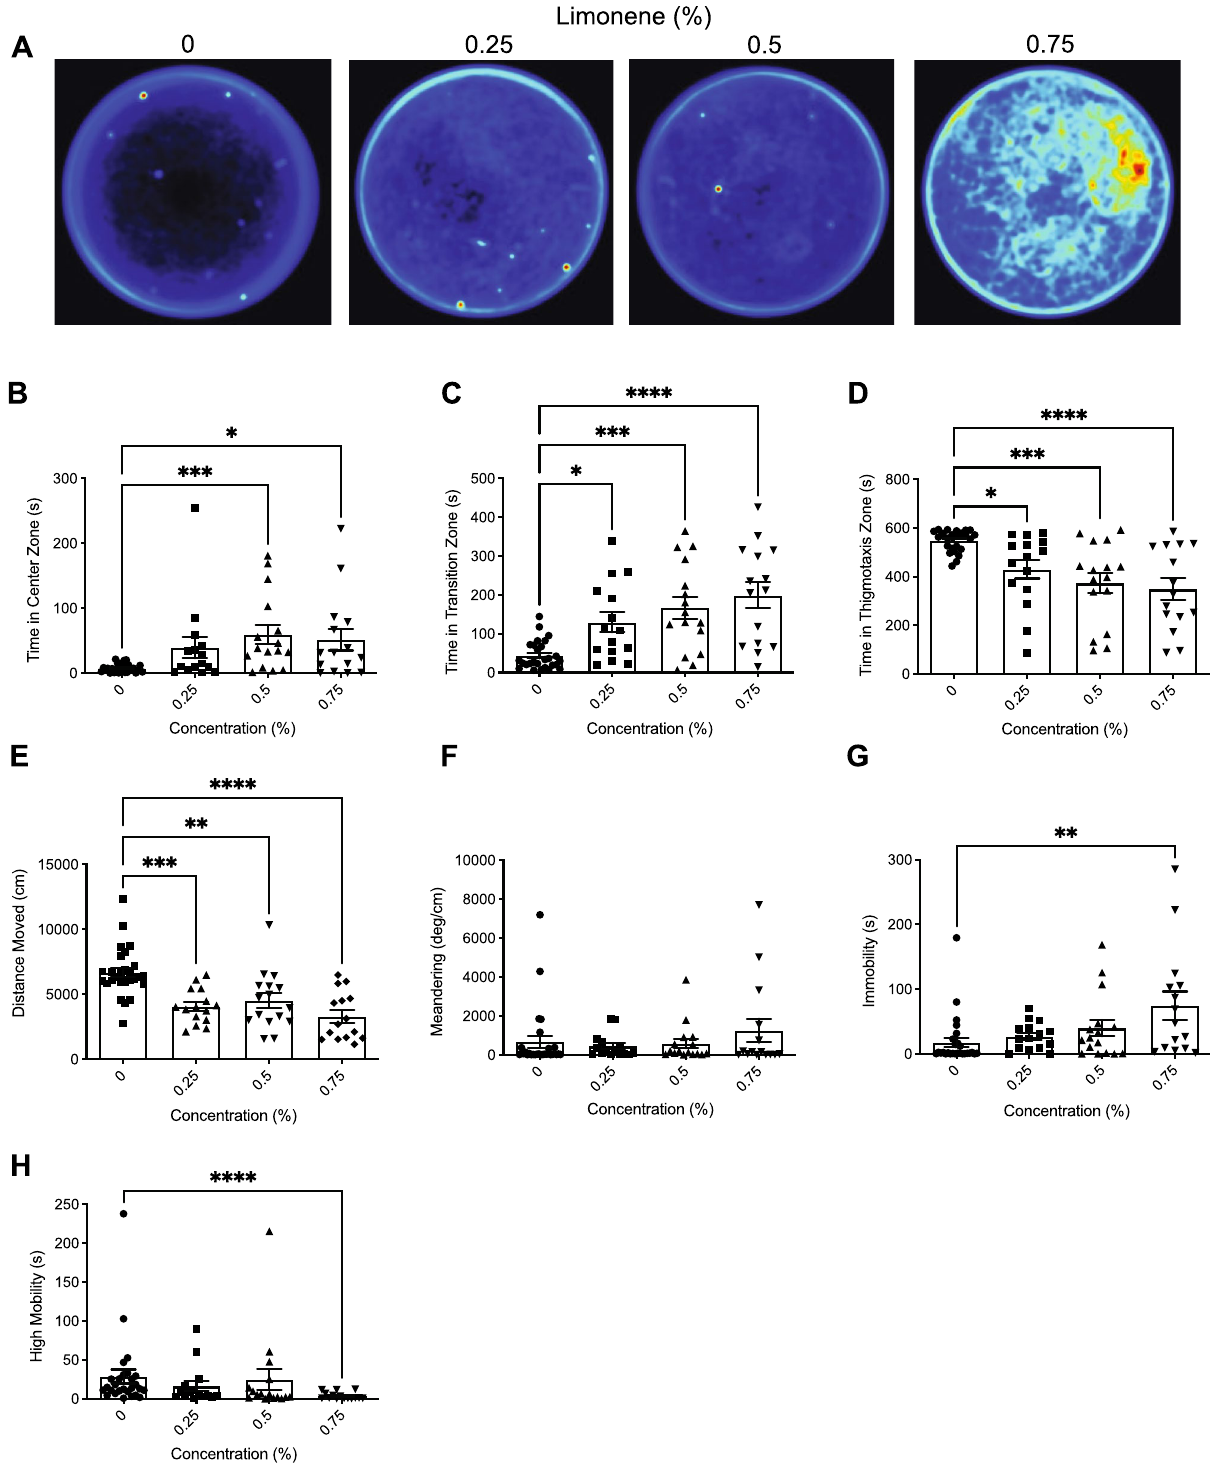
Figure 1. The effects of acute limonene administration on zebrafish behaviour assessed by the open field test. ( A ) Group heatmaps showing a coloured representation of the combined mean location of each group of fish across all trials. Average time spent in the center ( B ), transition ( C ), and thigmotaxis ( D ) zone during the open field test. Fish locomotion was quantified in the open field test by measuring distance moved ( E ), meandering ( F ), time spent immobile ( G ), and time spent highly mobile ( H ). All data are presented as mean ± S.E.M. Significant differences between controls and limonene treated groups are indicated by *( P < 0.05), **( P < 0.01), ***( P < 0.001), and ****( P <